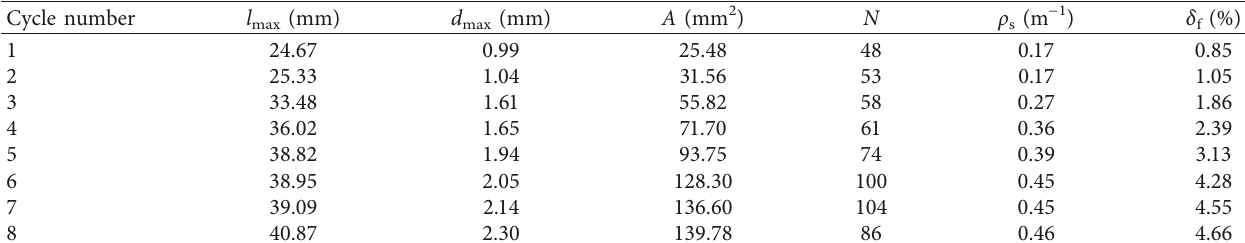
Figure 7: Scanning electron microscopy images of the sample surface after different wetting and drying cycles. (a) Original sample. (b) Cycle one. (c) Cycle four. (d) Cycle eight. Table 2: Crack parameters of the completely disintegrated carbonaceous